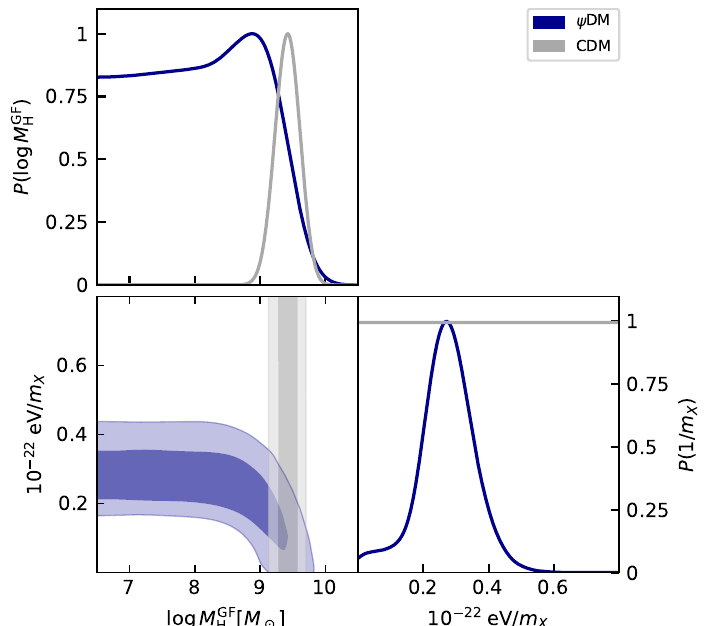
Figure 5. MCMC posterior distributions in the ψ DM scenario (blue contours/lines), for the threshold halo mass for galaxy formation M GF , and the inverse of the DM particle’s mass 10 − 22 eV/ m X . H For reference, the outcomes in the standard CDM scenario are also reported (grey contours/lines). The contours show 68% and 95% confidence intervals, and the marginalized distributions are in arbitrary units (normalized to 1 at their maximum